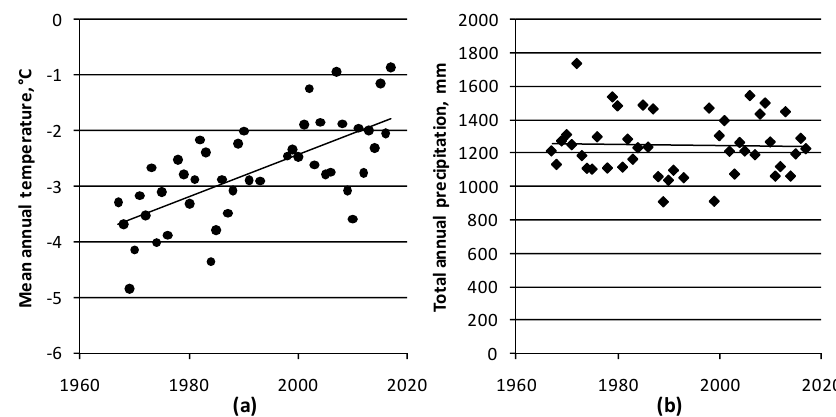
Figure 2. Long-term climatic trends over the area of research: ( a ) Annual mean temperatures; ( b ) Total annual precipitation. Straight lines give an idea of linear components of the trends. The slope of the temperature trend (~0.038) is significant at p < 0.05, R 2 = 0.45. The slope of precipitation trend (~ − 0.343) is not significant. Table 1. A summary of the measured values of the pool of photosynthetic pigments at various altitudes in the vicinity of the timberline of West Sayan ridge. Sp = sample point, Chl = chlorophyll.